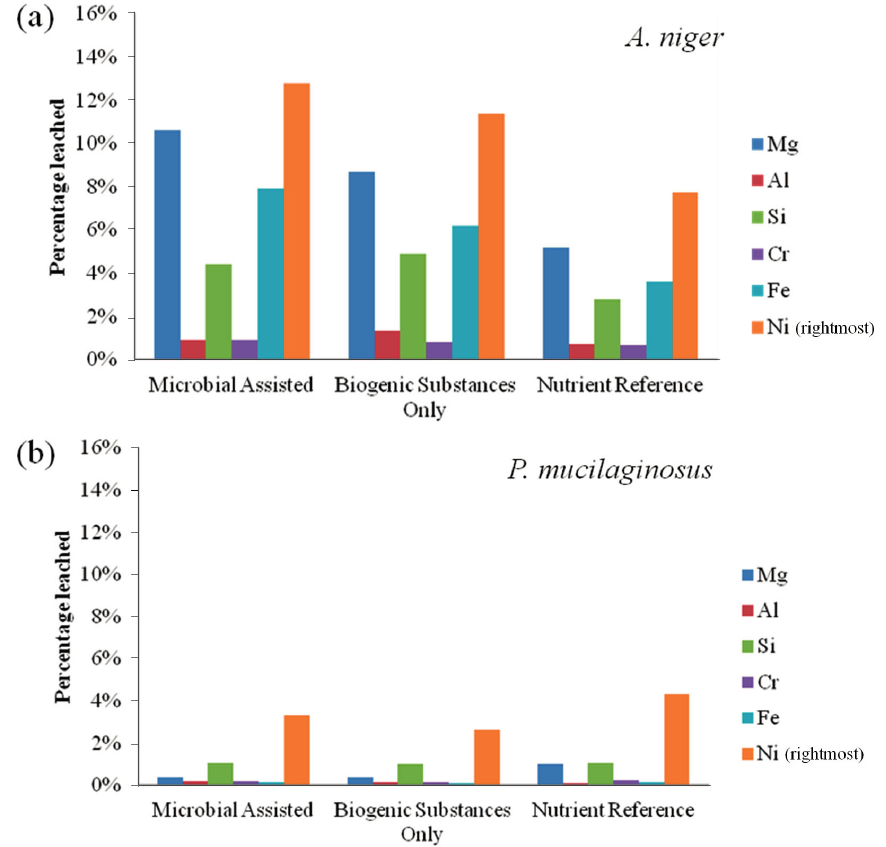
Figure 1. ( a ) Elemental leaching extent by Aspergillus niger from fresh olivine over 21 days; and ( b ) elemental leaching extent by Paenibacillus mucilaginosus from fresh olivine over 21 days.